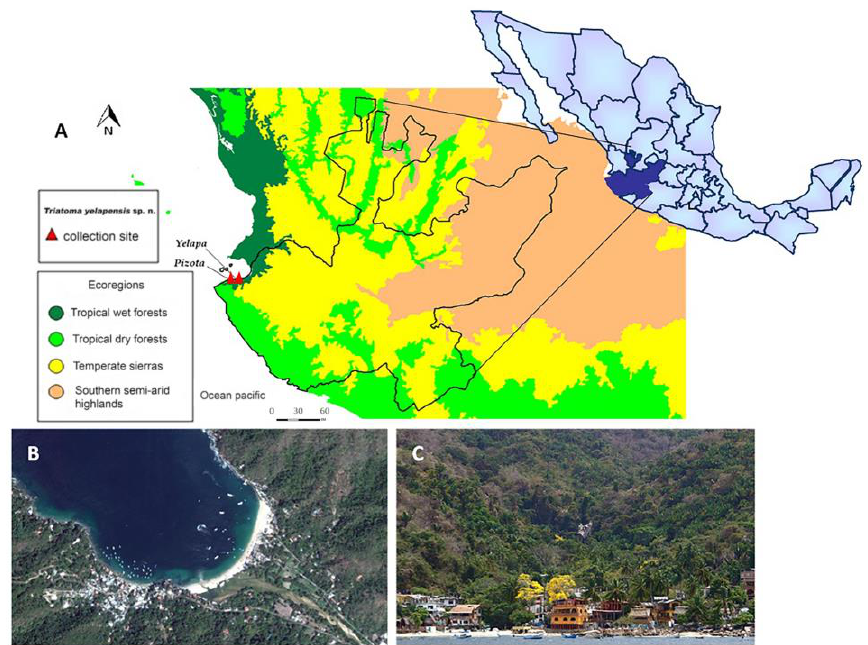
Figure 1. Geographic location of Yelapa and Pizota localities, municipality of Cabo Corrientes, Jalisco. ( A ) Location and ecoregions related to the collection points of Triatoma yelapensis n. sp. ( B ) Aerial view. ( C ) Panoramic